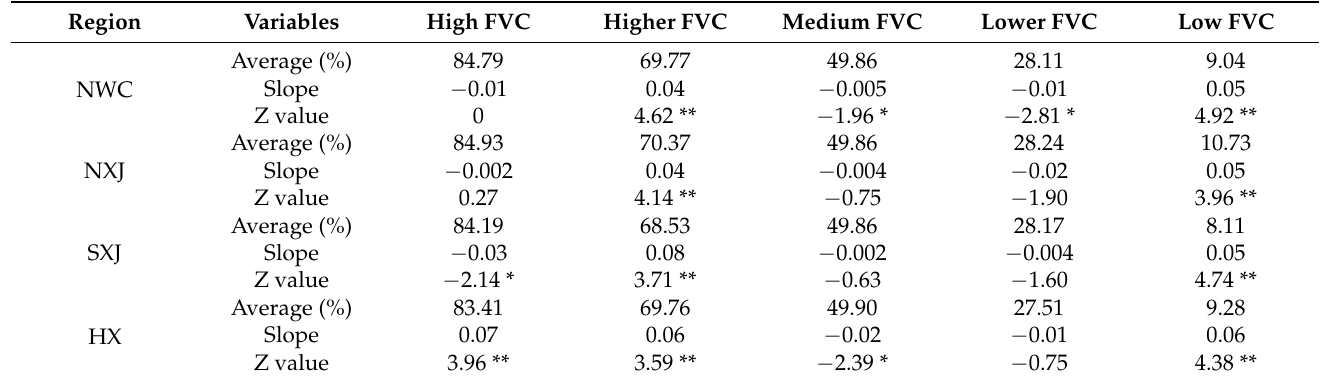
Table 3. FVC changes in different grades in NWC during 2000–2020.